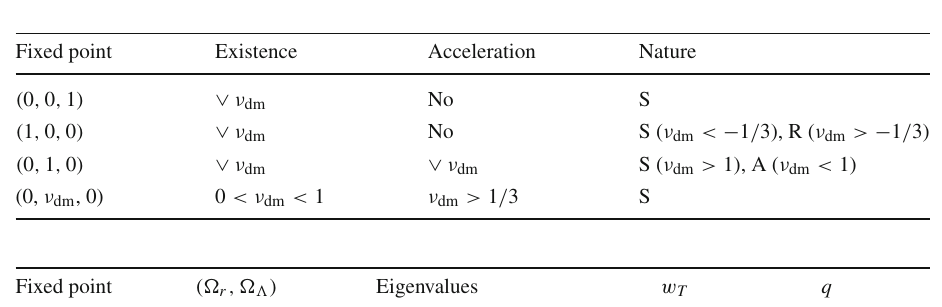
Table 3 Fixed points of model II